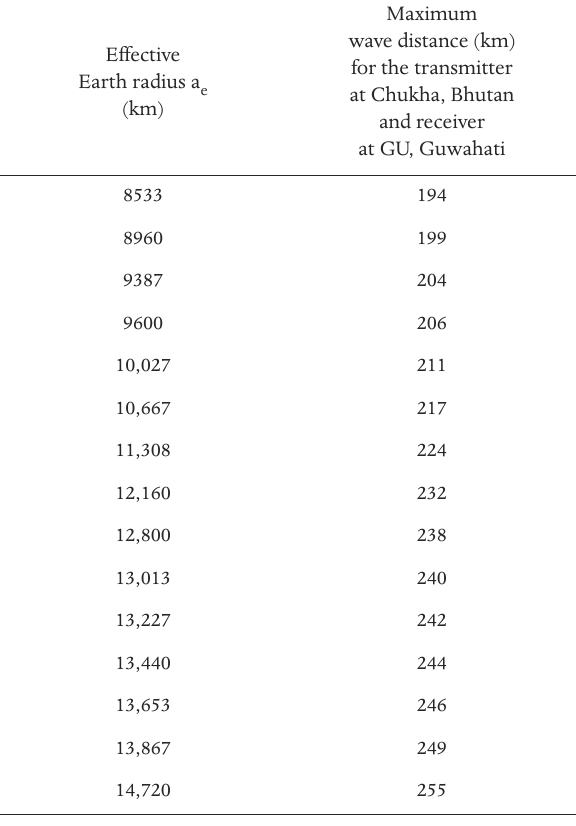
Table 1. The effective Earth radius and corresponding maximum wave distance relevant to the Trans- receiver location status, consid- ered in the study. Note that only when effective Earth radius factor goes around 13,400 km (i.e., when dN/dh = −80 N/km or more neg- ative) reception of signal from Chukha, station is expected to reach Guwahati, a condition obtained prior to the considered EQ